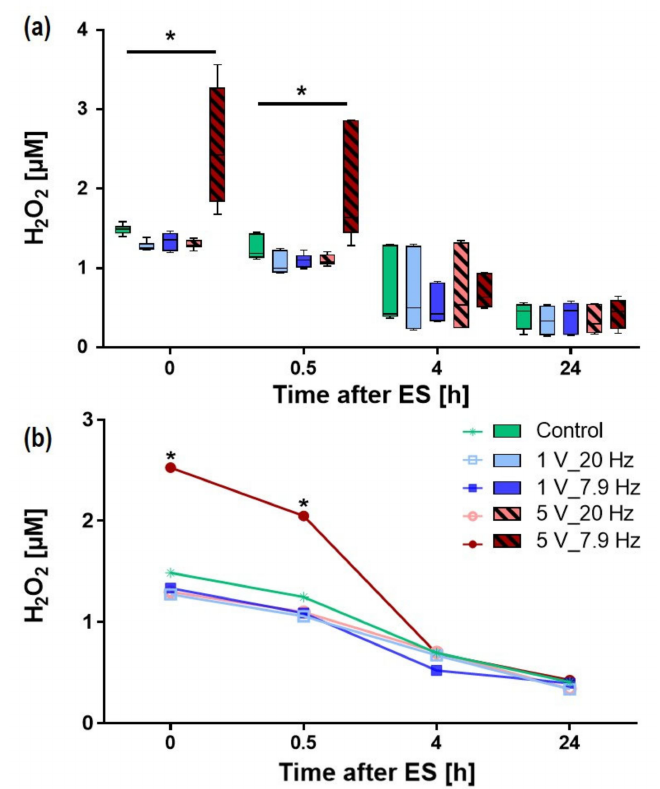
Figure 5. H 2 O 2 content of AC-stimulated liquids, i.e., the DMEM w/o pyruvate, after 10 min ES, ( a ) for all AC-stimulation parameters as BoxPlot graph, ( b ) time course of H 2 O 2 concentration. Note that 10 min AC with 1 V settings did not change the H 2 O 2 concentration in contrast to 5 V_7.9 Hz with a significant increase in H 2 O 2 up to 0.5 h. (Median ± min/max, n = 5–6, two-way ANOVA posthoc Bonferroni, * p < 0.05 compared to